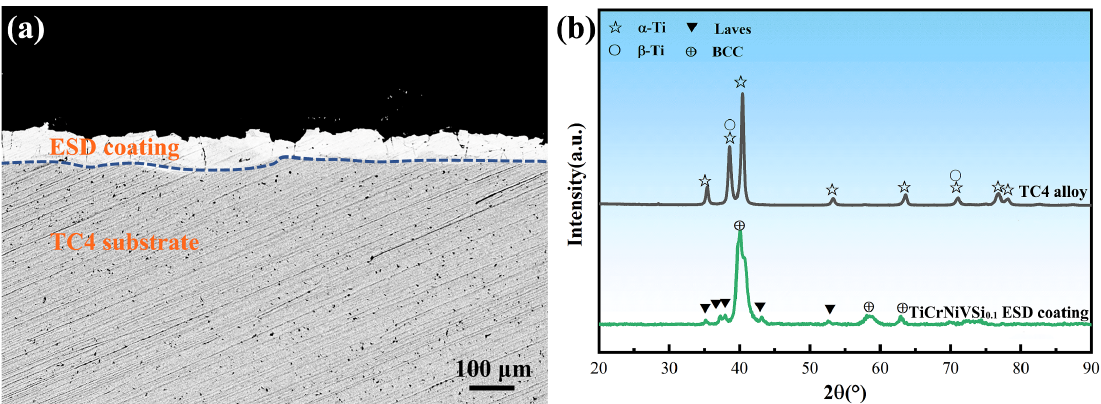
Figure 4. Cross-section morphology ( a ) and XRD pattern ( b ) of TiCrNiVSi 0.1 ESD coating deposited on a TC4 alloy substrate under the optimized process parameters.